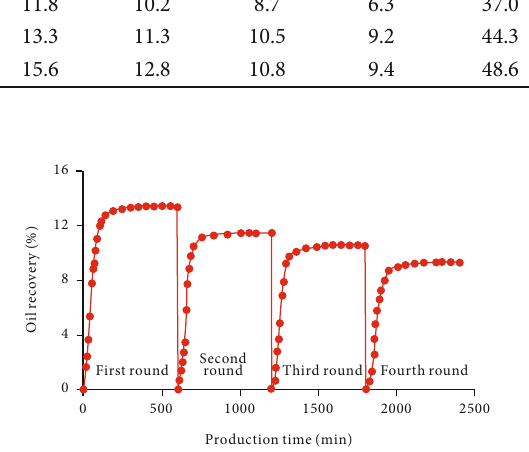
Figure 3: Relationship between water hu ff -pu ff recovery and production time (core with a fracture length of 6